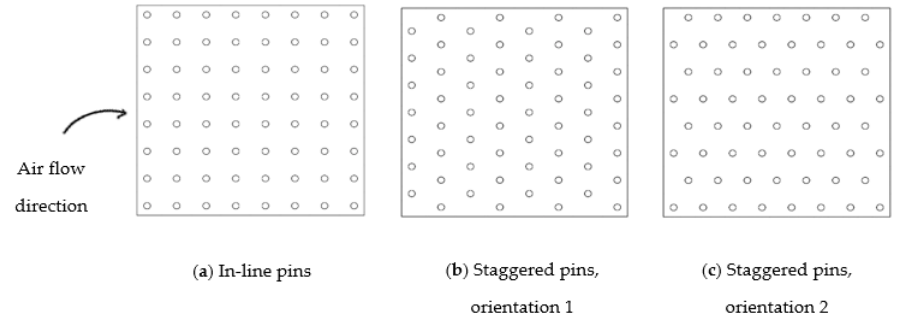
Figure 11. Best fin heat sink (among those studied).